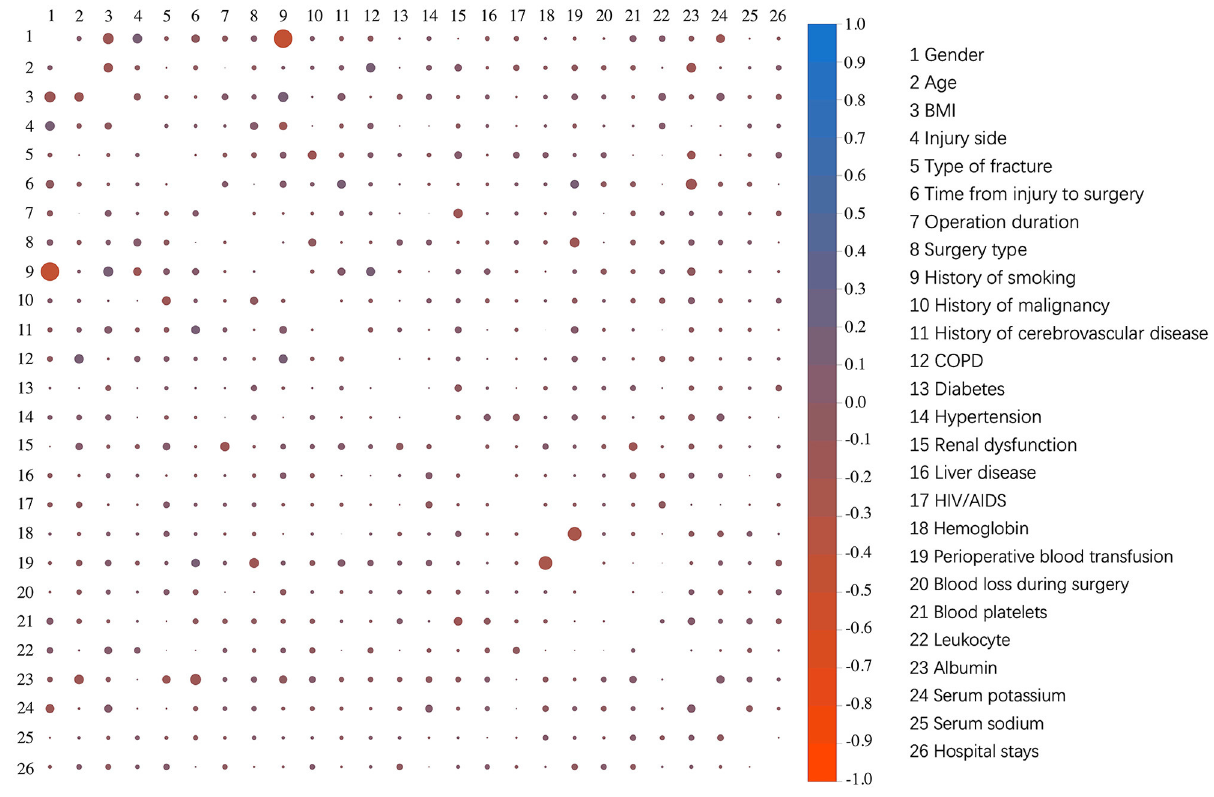
FIGURE 4 | The correlation analysis results of all variables.